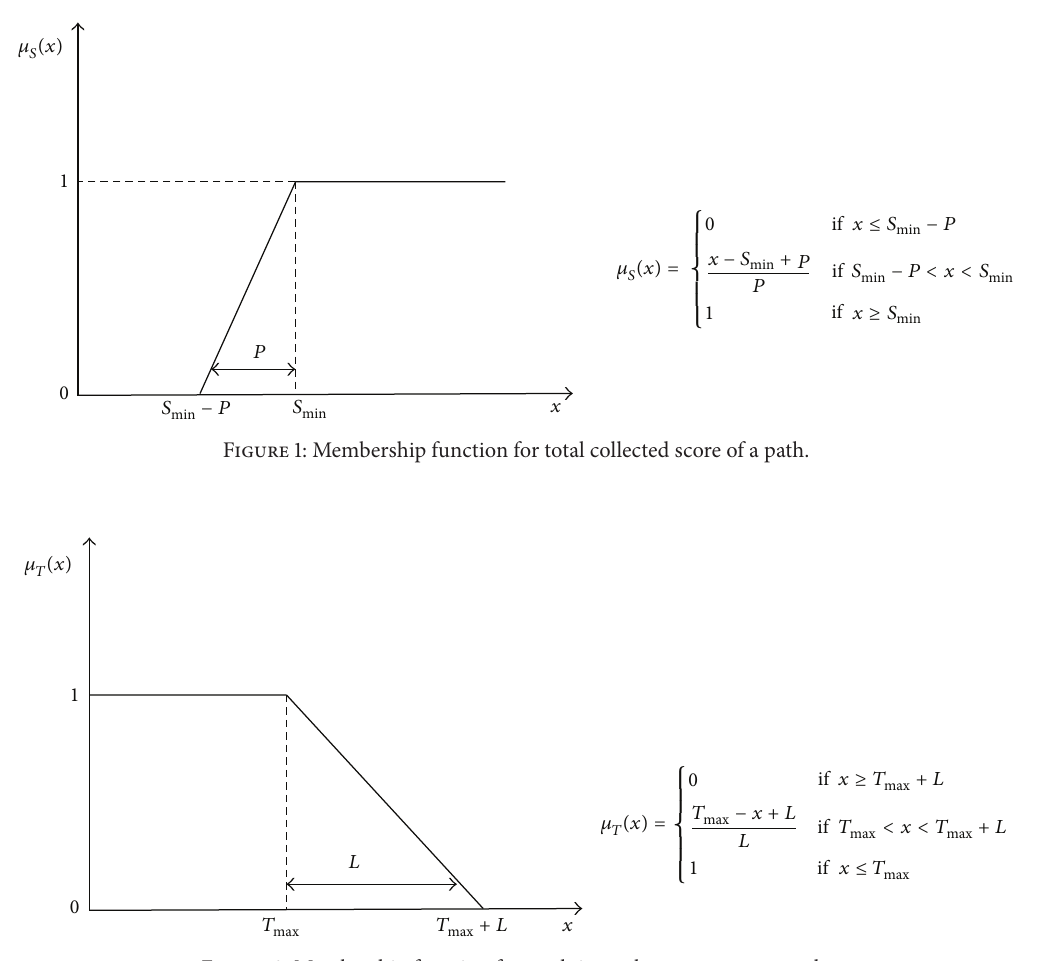
Figure 2: Membership function for total time taken to traverse a